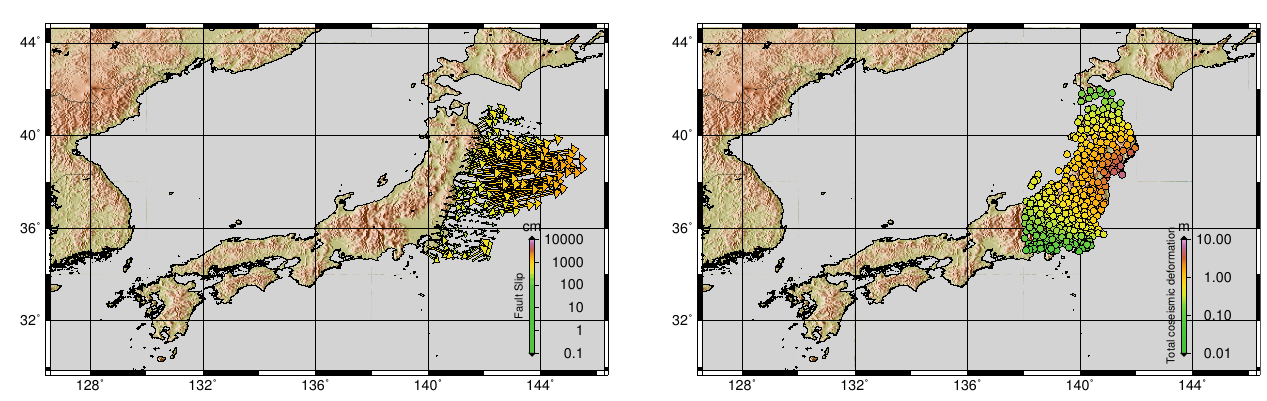
Figure 1. Finite fault model from NEIC (Hayes, 2011a). Colorbar slip magnitude in centimeters. Sizes of arrows proportional to slip; rake represented as the direction of the arrows. From the sizes of the arrows, the existence of displacements in a broad dynamical range is clear, covering at least 6 orders of magnitude.